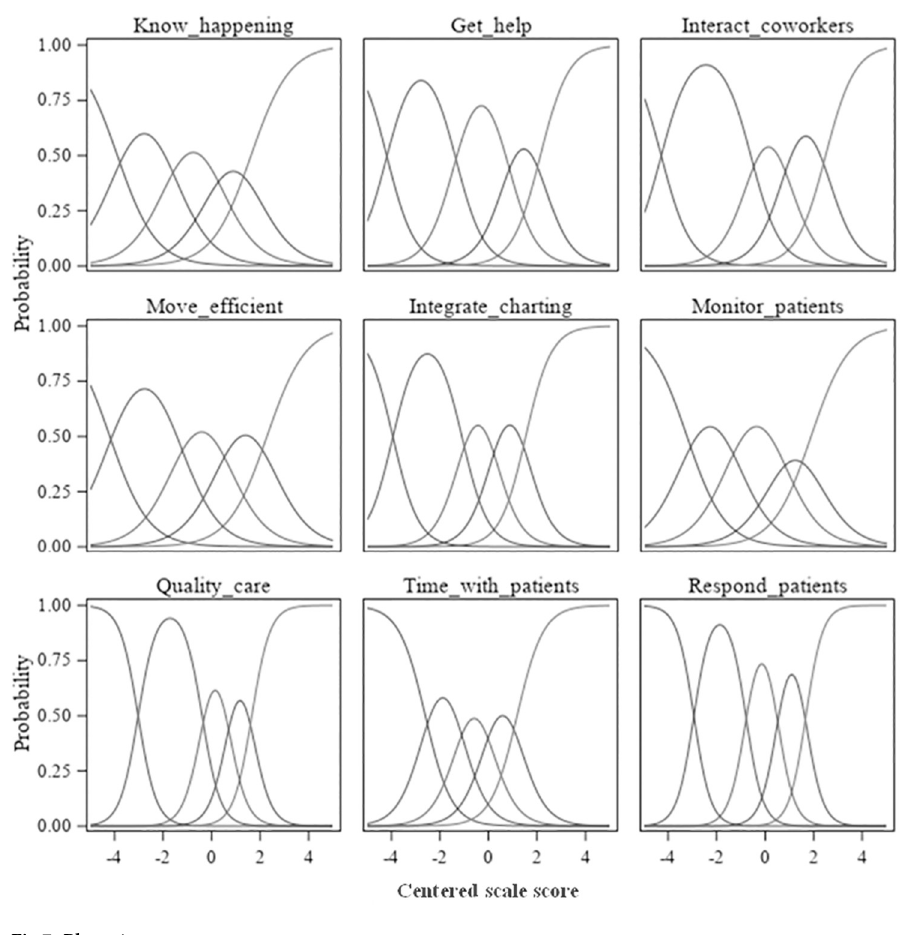
Fig 7. Phase 4 category response curves.